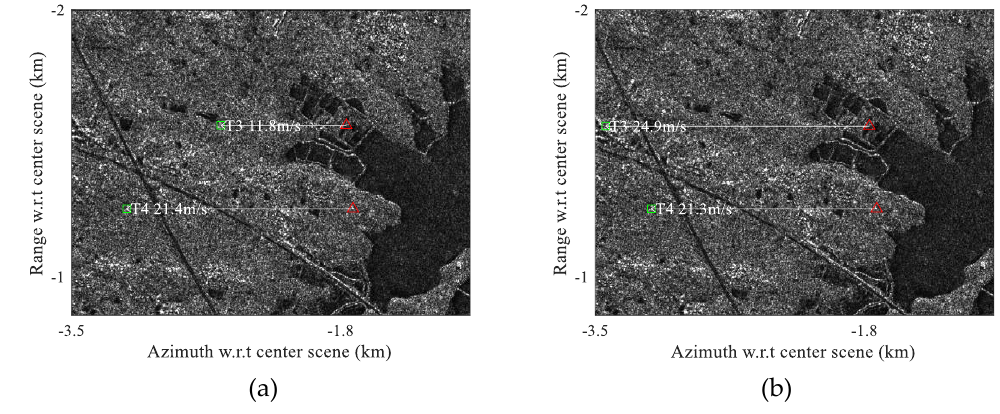
Figure 18. Comparison of across-track velocity estimation for along-track interferometry (ATI) and AMF: ( a ) original ATI phase is used to estimate across-track velocity; and ( b ) AMF is used to estimate target’s ATI phase and across-track velocity.